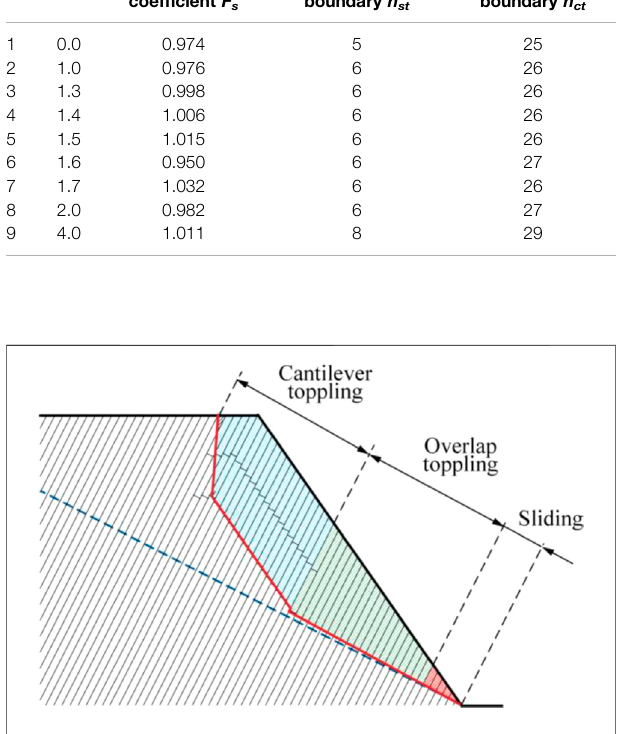
TABLE 1 | Calculation table of failure plane search of the south Anhui slope under the action of a horizontal quasi-static force.